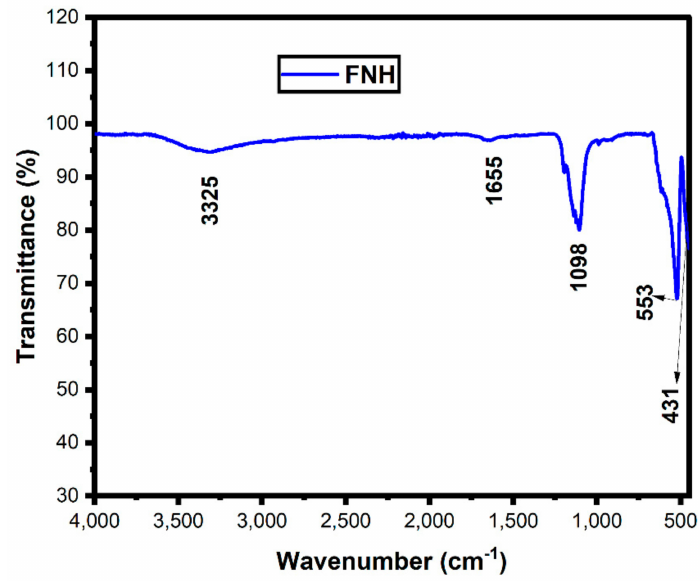
Figure 4. FTIR spectrum of FNH nanoparticle.